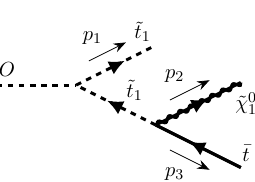
Figure 3. Diagram for scalar sgluon decay to a light stop, a top antiquark, and the lightest neutralino, assumed to be pure Higgsino. The other signi(cid:12)cant ~ t 1 -mediated decay is given by replacing (cid:22) t ! (cid:22) b and ~ (cid:31) 0 ! ~ (cid:31) (cid:0) . Similar decays exist for heavy 1 1